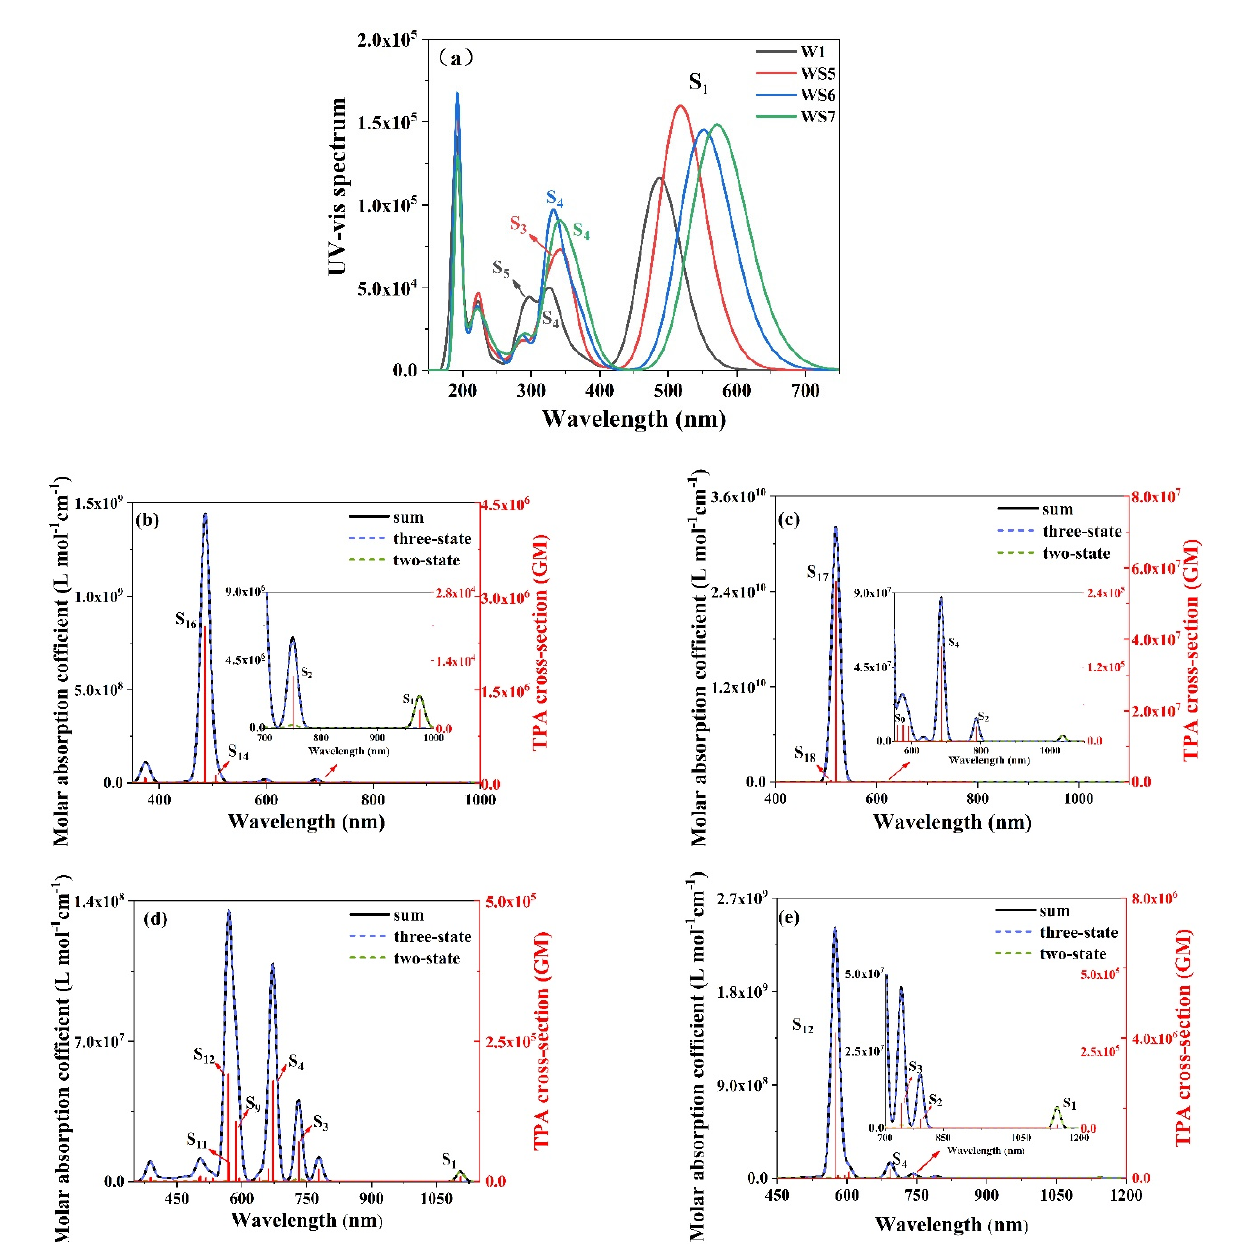
Figure 2. OPA UV-vis ( a ) and TPA spectra ( b – e ). The gray, red, blue, and green lines represent W1, WS5, WS6, and WS7, respectively. The black, blue, and green lines in ( b – e ) represent the sum, three-state, and two-state terms, respectively. Table 1. Excited state information for the first excited state of the four molecules. Molecule